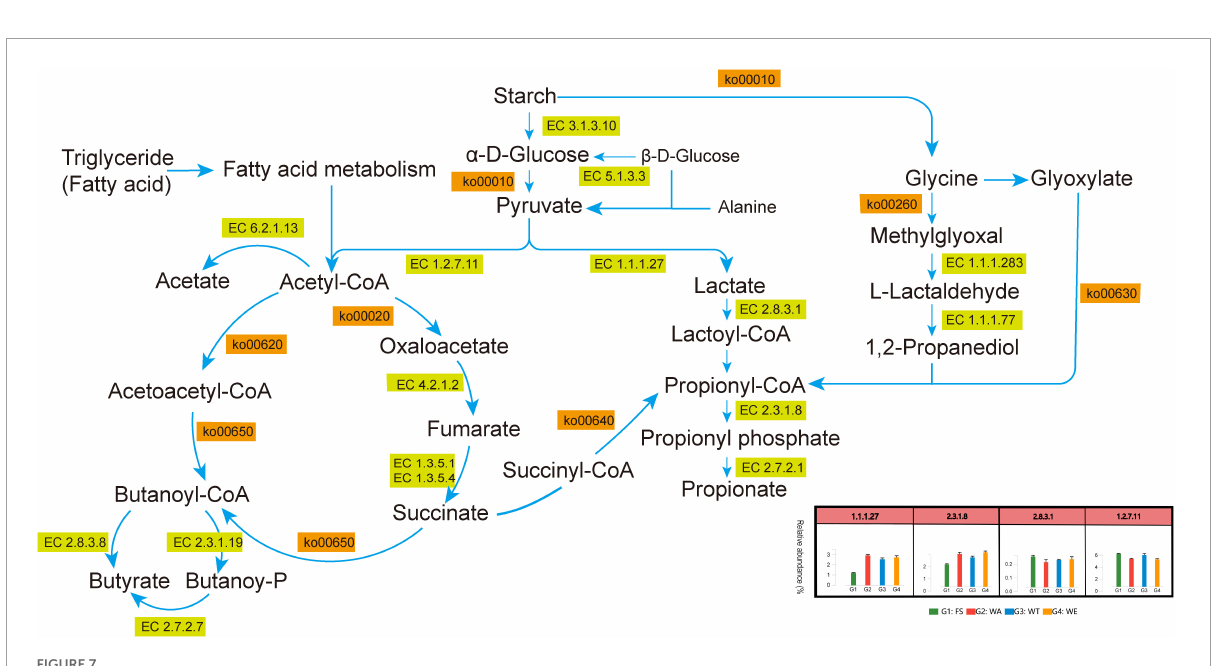
FIGURE7 Metabolic pathways of SCFAs produced after in vitro